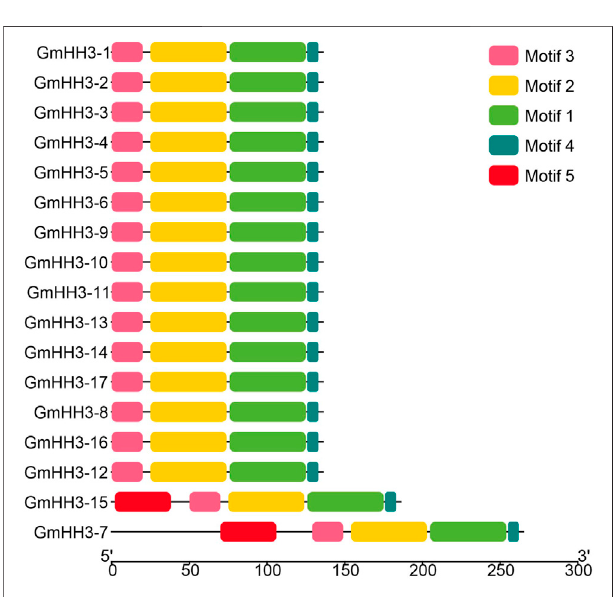
FIGURE 5 | Conserved motifs in GmHH3